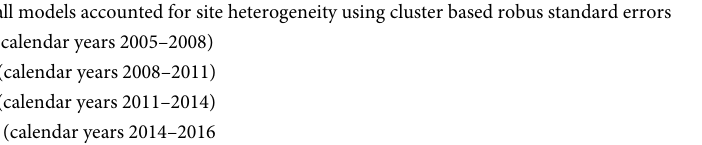
than males (HR 0.85, 95% CI 0.78–0.93) and this difference persisted during the years 6–8. After adjusting for guideline period, age at ART start and reason for starting ART, females had a lower risk of LTFU in all periods after ART initiation compared to males (aHR 1 st year 0.75, 95% CI 0.72–0.78; 2 nd year 0.73, 95% CI 0.68–0.79; 2–5 years 0.77, 95% CI 0.70–0.84, 6–8 years to the second for the first year of ART (HR 0.81, 95% CI 0.67–0.98), this difference persisted in the multivariable model (aHR 0.80, 0.66–0.97). There were only small differences in LTFU risk between guideline periods for all years on ART (Table 2). Infants aged 0–2 years and young adults aged 15–24 years had the highest risk of LTFU during the years 1–5 on ART in both the univariable and the multivariable model. During the years 6–8 children aged 6–14 had the